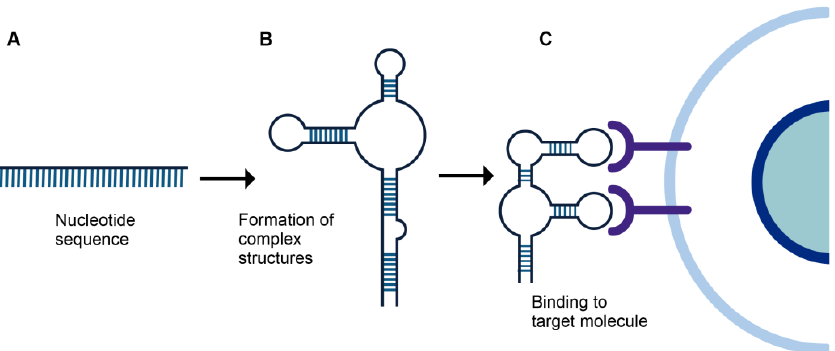
Figure 1. Schematic representation of unfolded, folded, and binding of aptamers to a target molecule. ( A ) Unfolded single strand aptamer. ( B ) Folding of the aptamer by base pairing and tertiary interactions. ( C ) Final structure of the aptamer capable of binding to a specific target molecule.